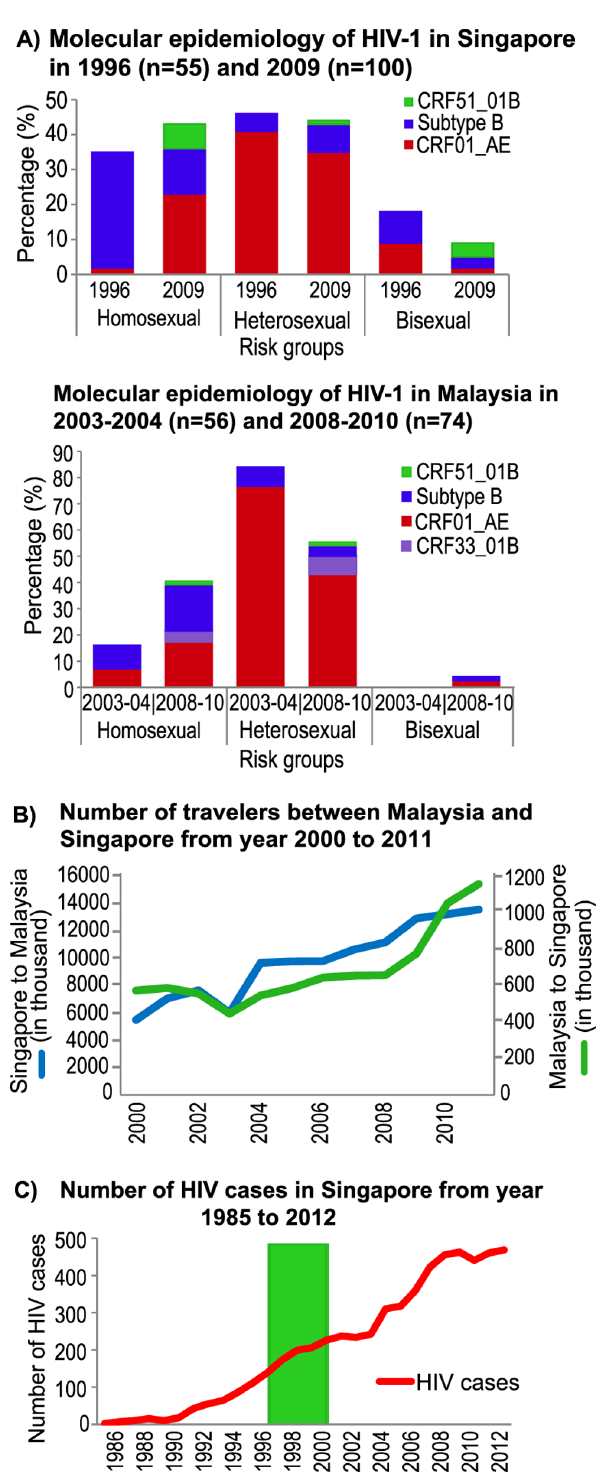
Figure 3. HIV-1 epidemiology and traveling trend in Singapore and Malaysia. A . The molecular epidemiological pattern of HIV-1 in Singapore between 1996 and 2009 are delineated in the bar chart. A significant shift from majority subtype B to CRF01_AE was evident among the homosexual group, while the subtype distribution in the heterosexual risk group remained relatively stable between 1996 and 2009. New detection of CRF51_01B was observed across all sexual risk groups in 2009. On the other hand, subtype distribution patterns in Malaysia between 2003–2004 and 2008–2010 remained